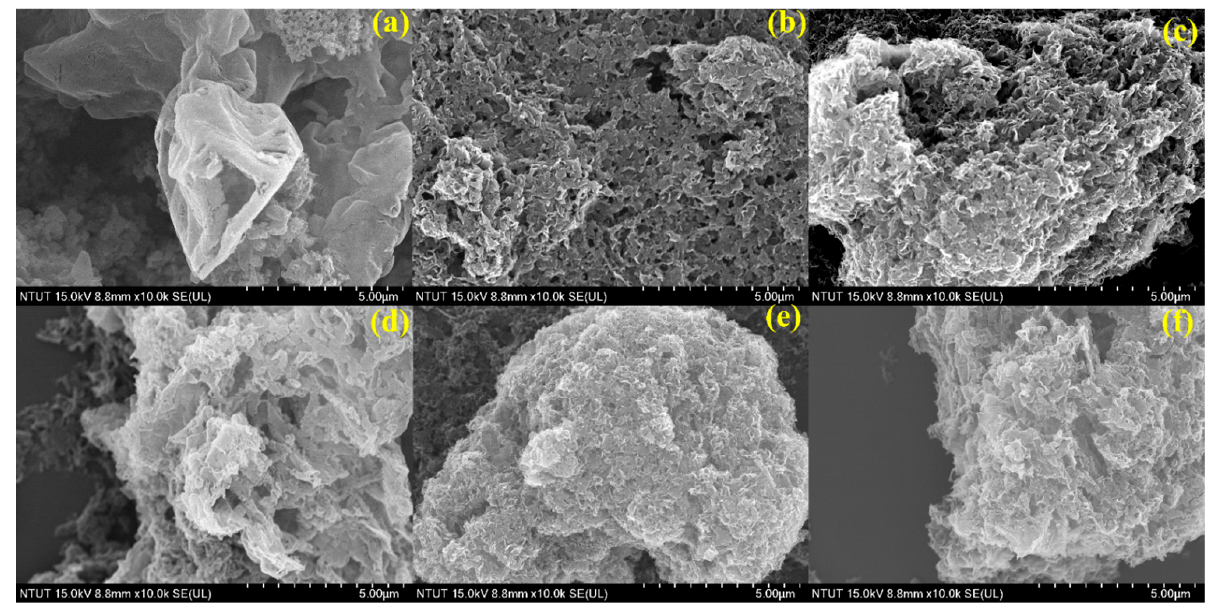
Figure 4. Surface morphology studies of bulk gCN and V/Cu/gCN nanosheets: ( a ) bulk gCN ( b ) VC-1, ( c ) VC-2, ( d ) VC-3, ( e ) VC-4, and ( f ) VC-5.